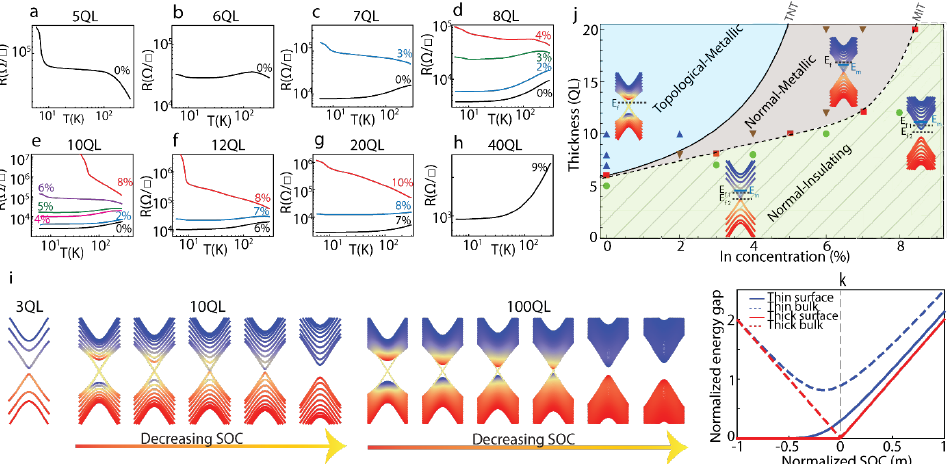
Figure 9: Topological and metal insulator transitions in interface-engineered (Bi In ) Se films . Temperature-dependence of sheet resistance for a, 5 QL with 1-x x 2 3 0% In, b, 6 QL with 0% In, c, 7 QL with 0% and 3% In, d, 8 QL with 0%, 2%, 3% and 4% In, e, 10 QL with 0%, 2%, 4%, 5%, 6% and 8% In, f, 12 QL with 6%, 7% and 8% In, g, 20 QL with 7%, 8% and 10% In, and h, 40 QL with 9% In. i, Schematic of the TPT (topological phase transition) process for different thicknesses and as a func- tion of SOC weakening (due to In substitution). j, Phase diagram for the interface- engineered samples: the dashed line is a guide to eye for the MIT (metal insulator transition) boundary. Blue triangles correspond to topological-metallic data points l > 1, green circles are normal-insulating data points with k l < 1, brown where k F F l > 1, red squares with k l = 1 triangles show normal-metallic data points with k F F and the MIT line goes through these points. The Ioffe-Regel criterion can be used to quantitatively identify the MIT point. Following this criterion, a material becomes = (2 π n l > 1 and insulator if k l ≤ 1, where 2D Fermi vector k ) 1 / 2 metal if k F F F sheet ) 1 / 2 [ 273, 274 ] . In the normal insulating and mean-free path l = ( (cid:125) h µ / e ) ( 2 π n sheet region, E and E represent two possible locations of the surface Fermi level, the F1 F2 former below the mobility edge (represented by E ) and the latter inside the surface m hybridization gap, which is an ideal case, where the MIT and TNT lines will over- lap. On the other hand, without the interface engineering scheme, the surface Fermi level is high and above the bottom of the conduction band, and the film remains metallic even after the TNT line and the MIT line cannot be detected via transport measurement [ 14, 163 ] . k, Simulated phase diagram. The critical point for TNT is well-defined in thick samples, but it is not indisputably definable in thin samples. The vertical dashed line (m = 0) shows the phase boundary in the infinite-size limit. Both axes are normalized by the Dirac velocity in this model (adapted from ref. [ 78 ] ). topological phase transition in finite-thickness TI films goes through two separate quantum phase transitions: first, topological-metal to normal-metal and then, normal-metal to